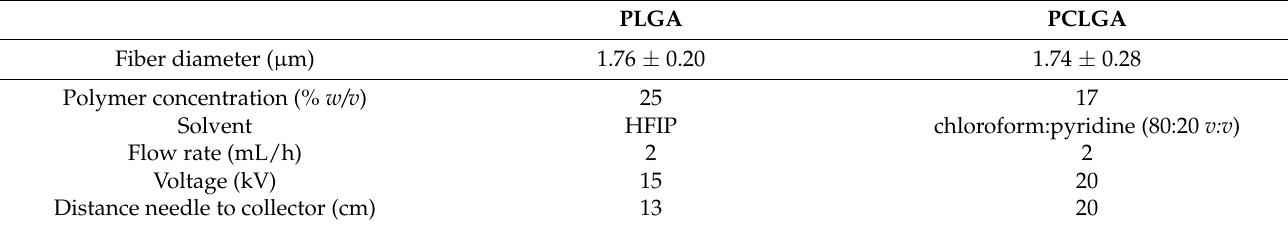
Table 1. Concentration and solvents of the PLGA and PCLGA solutions and electrospinning parameters to obtain membranes of 1.8 μ m thereof.